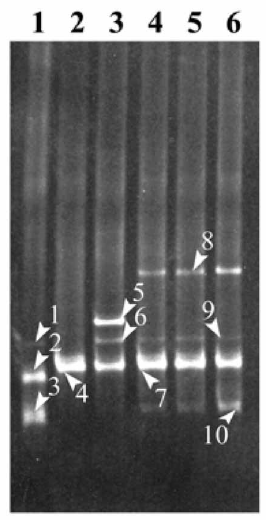
Figure 1. DGGE profiles of the total vaginal microbiota from the subject during the 6 weeks of study (lanes 1 to 6=weeks 1 to 6). See Table I for bacterial species associated with the arrowed bands shown